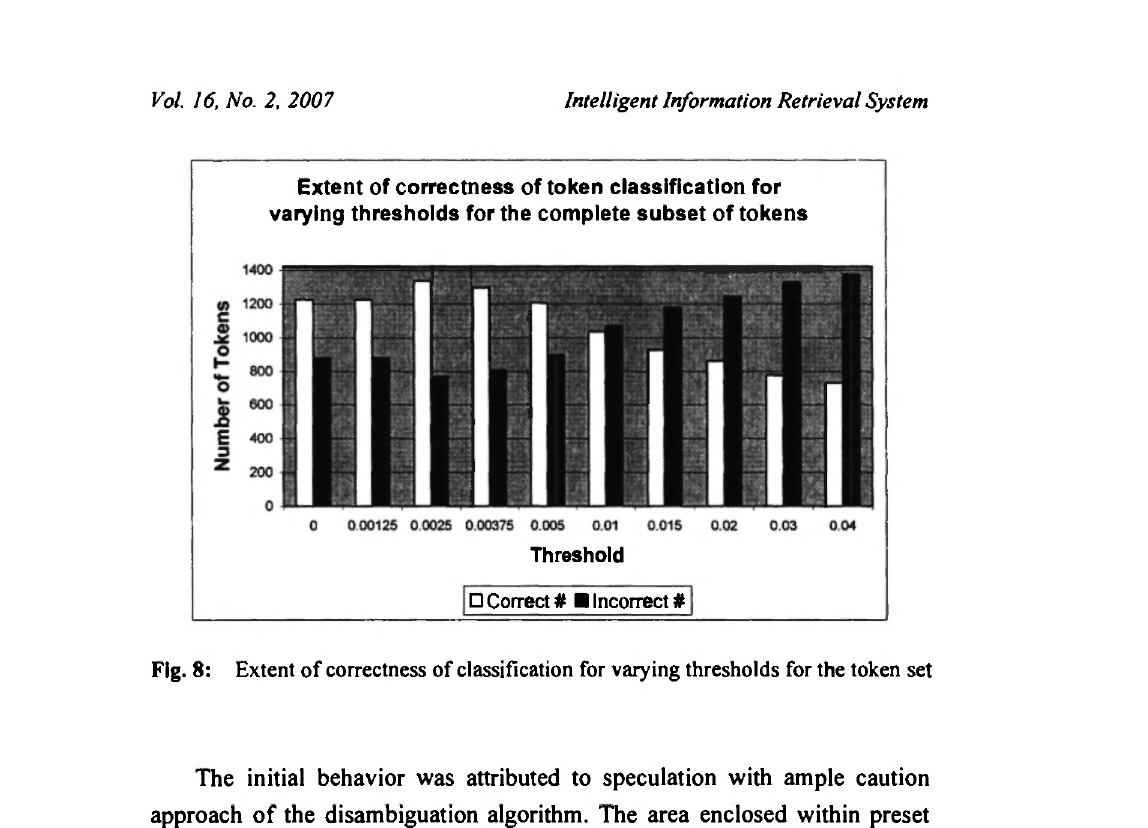
Fig. 8: Extent of correctness of classification for varying thresholds for the token